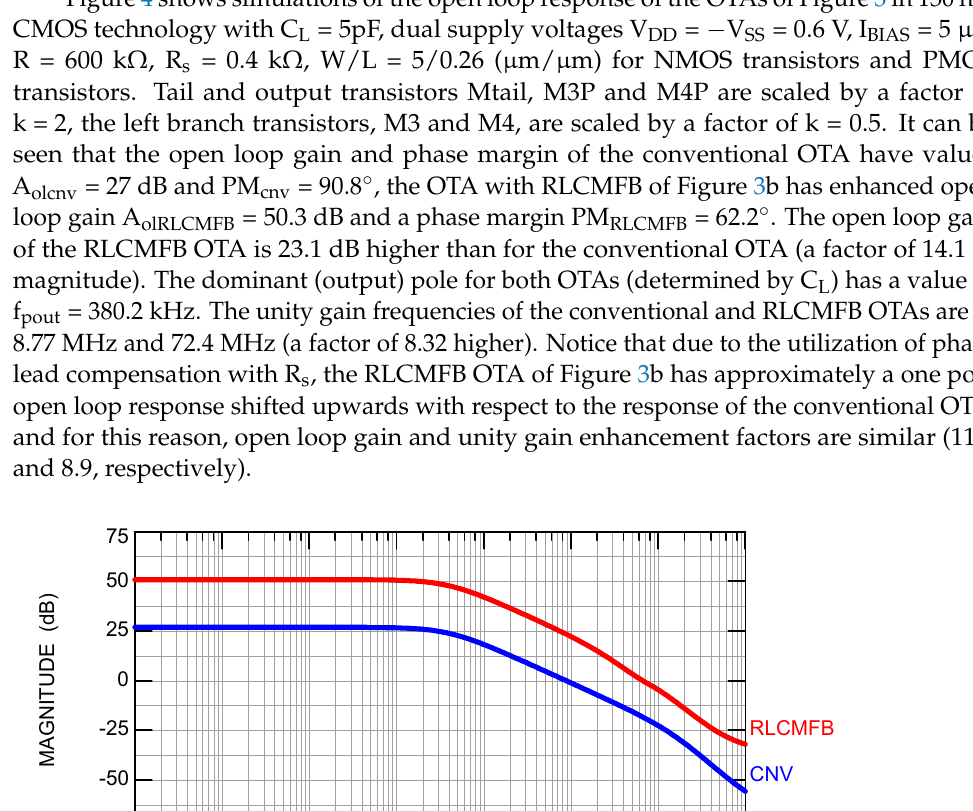
7 Table 1. Basic performance characteristics of OTAs of Figure 3. Parameter